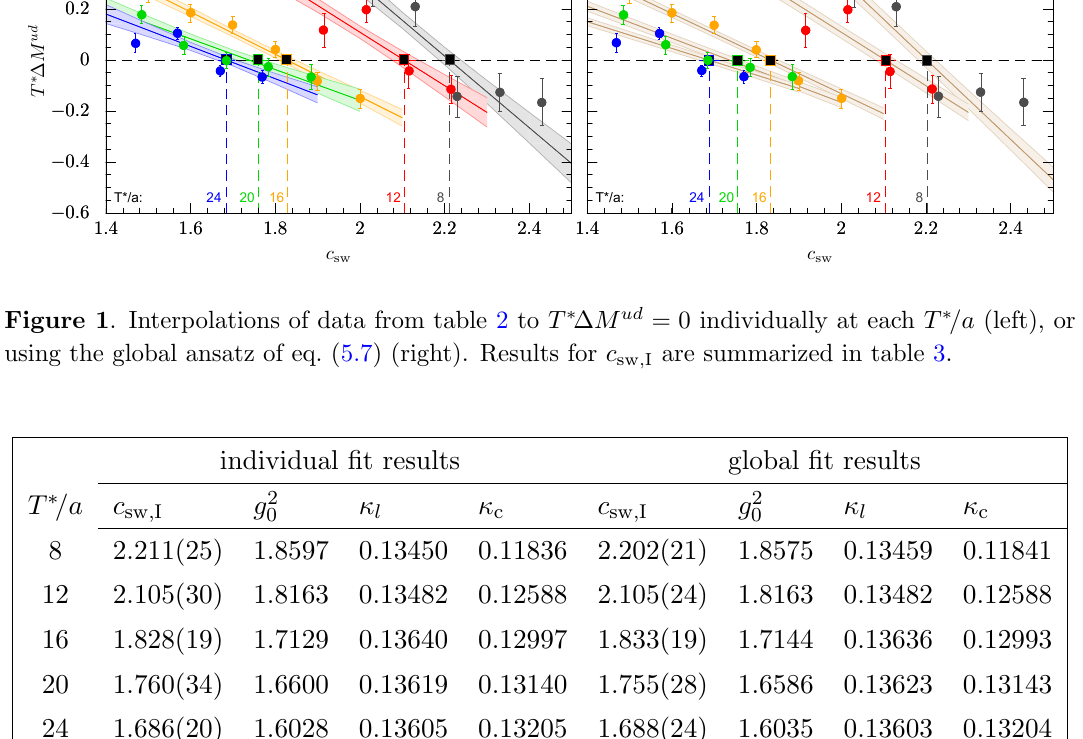
ud = 0 for individual (local) and a global (cid:12)t ansatz. (cid:3) M